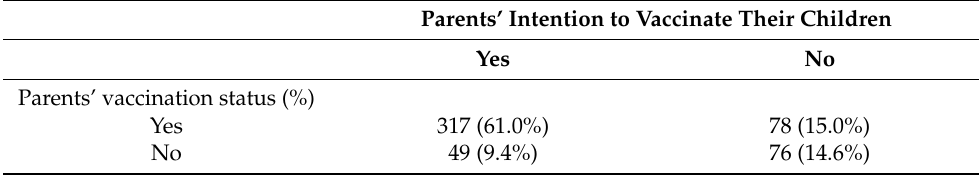
Table 2. Parents’ intention to vaccinate their children based on their own COVID-19 vaccination